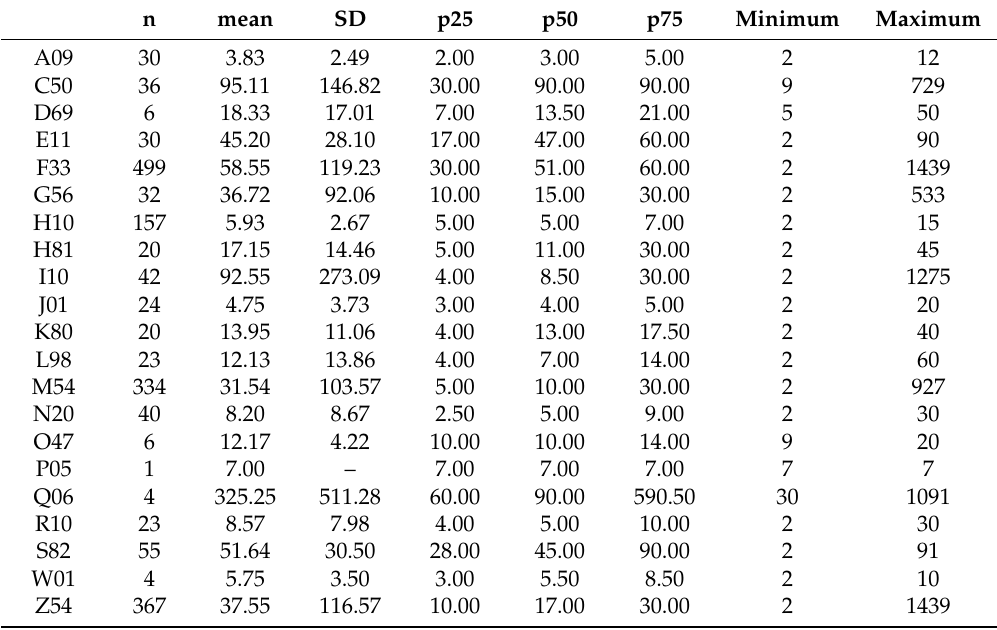
Table 2. Sick leave duration distribution of the 21 most prevalent diseases per ICD-10 chapter, in the first 20 expert examinations